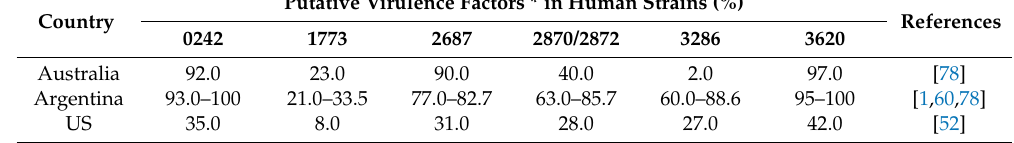
Table 6. Values (or range of values from different sources) of putative virulence factors frequency in human E. coli O157 strains isolated in different